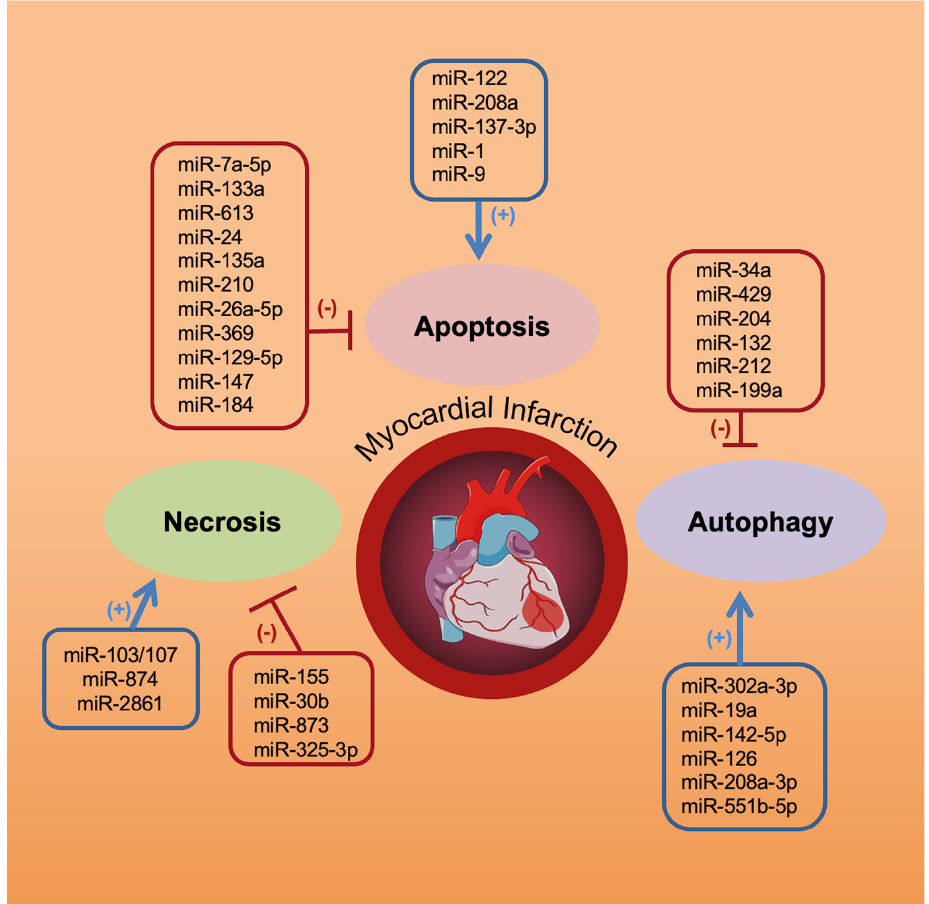
Figure 1. Schematic diagram depicting miRNAs orchestrating myocardial cell apoptosis, necrosis, and autophagy in myocardial